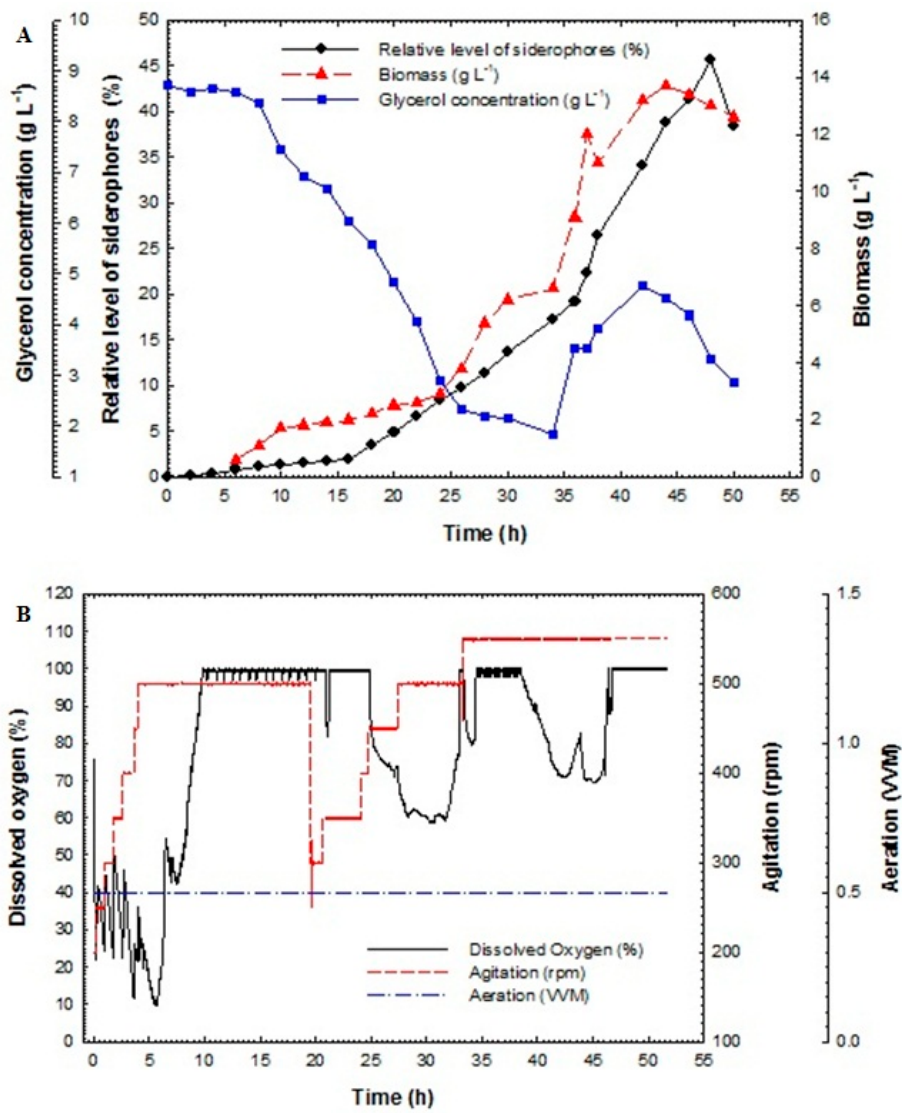
Figure 6A. The relative level of siderophores reached 1.92% at 16 h and increased rapidly to reach 19.24% at 36 h, achieving its maximum value of 45.59% at 48 h. The maximum biomass achieved was 13.7 g L − 1 at 44 h. Glycerol concentration decreased gradually and reached 2.89 g L − 1 at 24 h. After feeding, glycerol concentration increased gradually for some time to reach 4.75 g L − 1 at 42 h and decreased again to reach 2.85 g L − 1 at the end of the process. The dissolved oxygen decreased rapidly, therefore the concentration of oxygen was restricted to a value of 30% by increasing the speed of motor to the desired agitation rate. The rise of the agitation rate resulted in an increase in the dissolved oxygen concentration in the medium until 8 h; after this point dissolved oxygen increased gradually. Once feeding starts, the dissolved oxygen decreased rapidly, and consequently the agitation speed was increased gradually (Figure 6B). The fed-batch fermentation technique produced the highest percentage of relative level of siderophores of all methods, so cultures of P. aeruginosa F2 and P . fluorescens JY3 obtained by fed-batch fermentation were used for the preparation of talc formulations to be utilized as biocontrol agents.